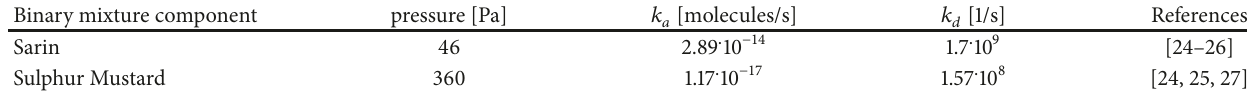
Table 1: Parameters used in simulations of binary adsorption on graphene in Figure 1.